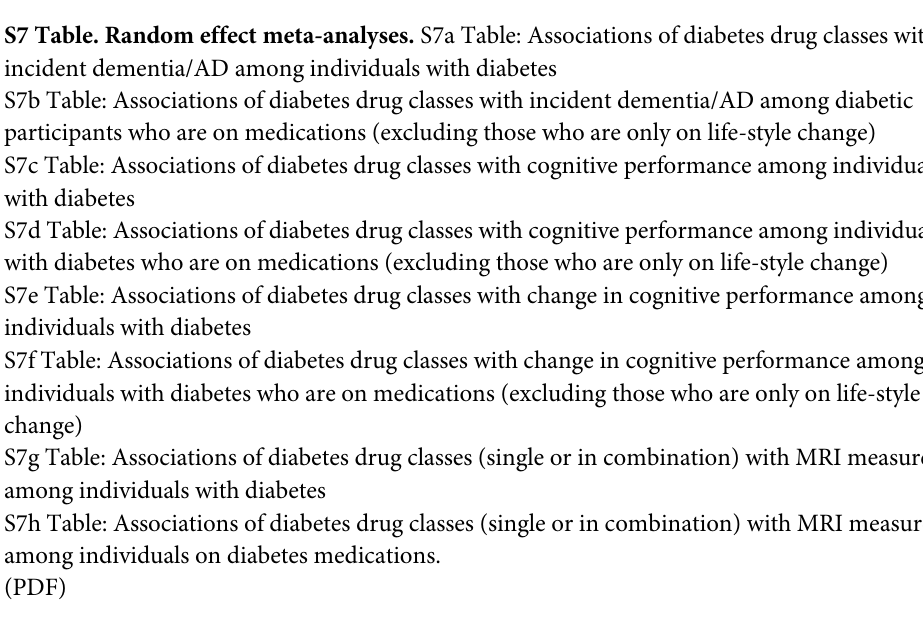
S7 Table. Random effect meta-analyses. S7a Table: Associations of diabetes drug classes with incident dementia/AD among individuals with diabetes S7b Table: Associations of diabetes drug classes with incident dementia/AD among diabetic participants who are on medications (excluding those who are only on life-style change) S7c Table: Associations of diabetes drug classes with cognitive performance among individuals with diabetes S7d Table: Associations of diabetes drug classes with cognitive performance among individuals with diabetes who are on medications (excluding those who are only on life-style change) S7e Table: Associations of diabetes drug classes with change in cognitive performance among individuals with diabetes S7f Table: Associations of diabetes drug classes with change in cognitive performance among individuals with diabetes who are on medications (excluding those who are only on life-style change) S7g Table: Associations of diabetes drug classes (single or in combination) with MRI measures among individuals with diabetes S7h Table: Associations of diabetes drug classes (single or in combination) with MRI measures among individuals on diabetes